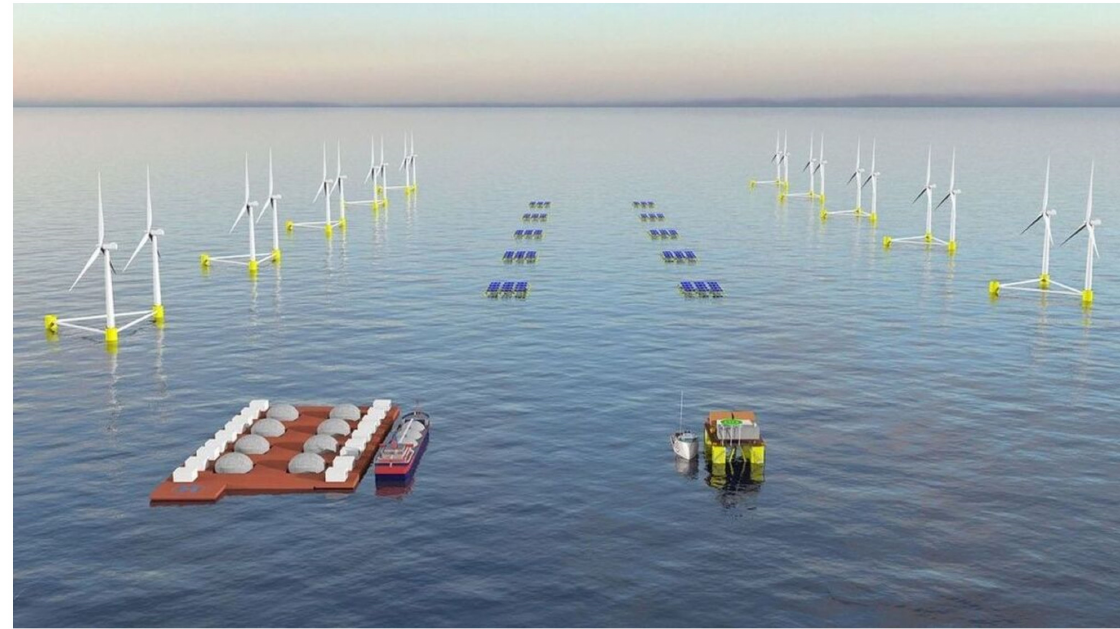
Figure 13. Offshore floating solar, wind, and green hydrogen (Source ©: Acciona